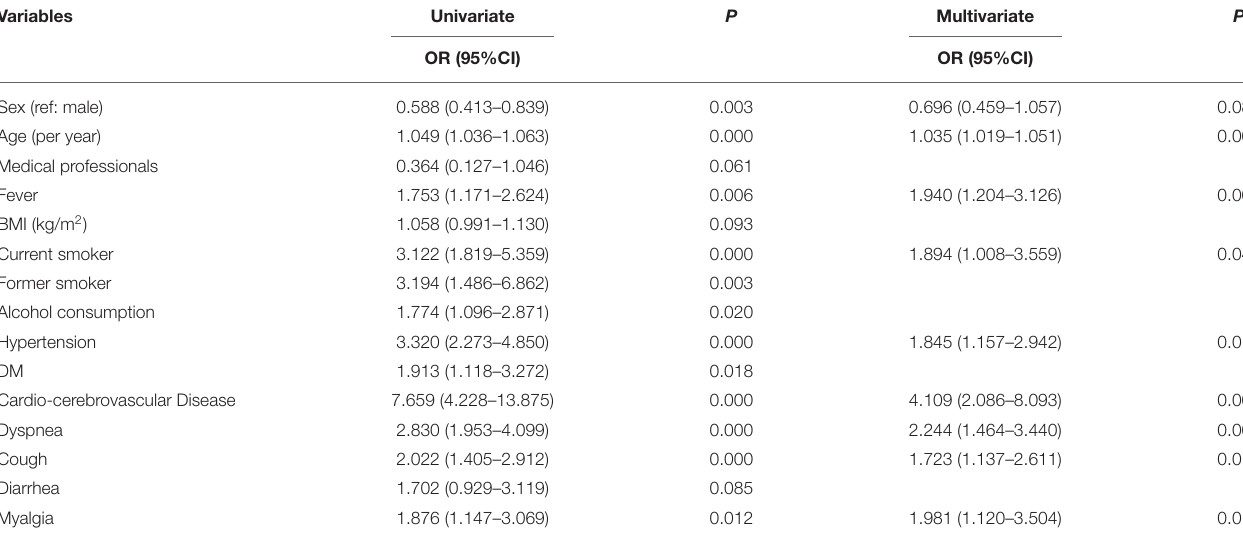
TABLE 2 | Risk factors associated with developing severe/critical group